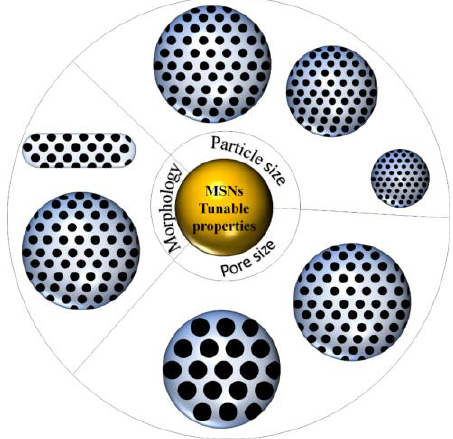
Figure 2. Schematic depiction of tunable MSNs’ properties.